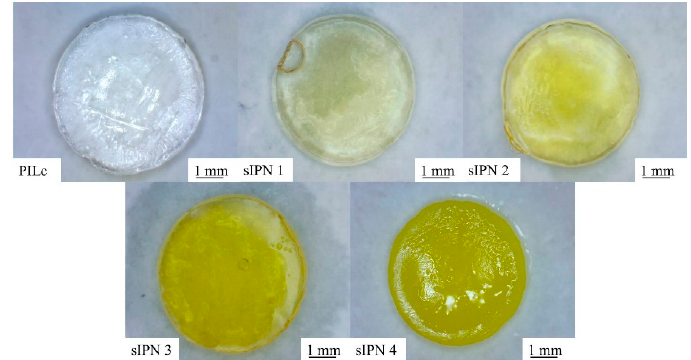
Figure 1. The photopolymerized hydrogels after swelling in DI water at 20 °C for 24 h.